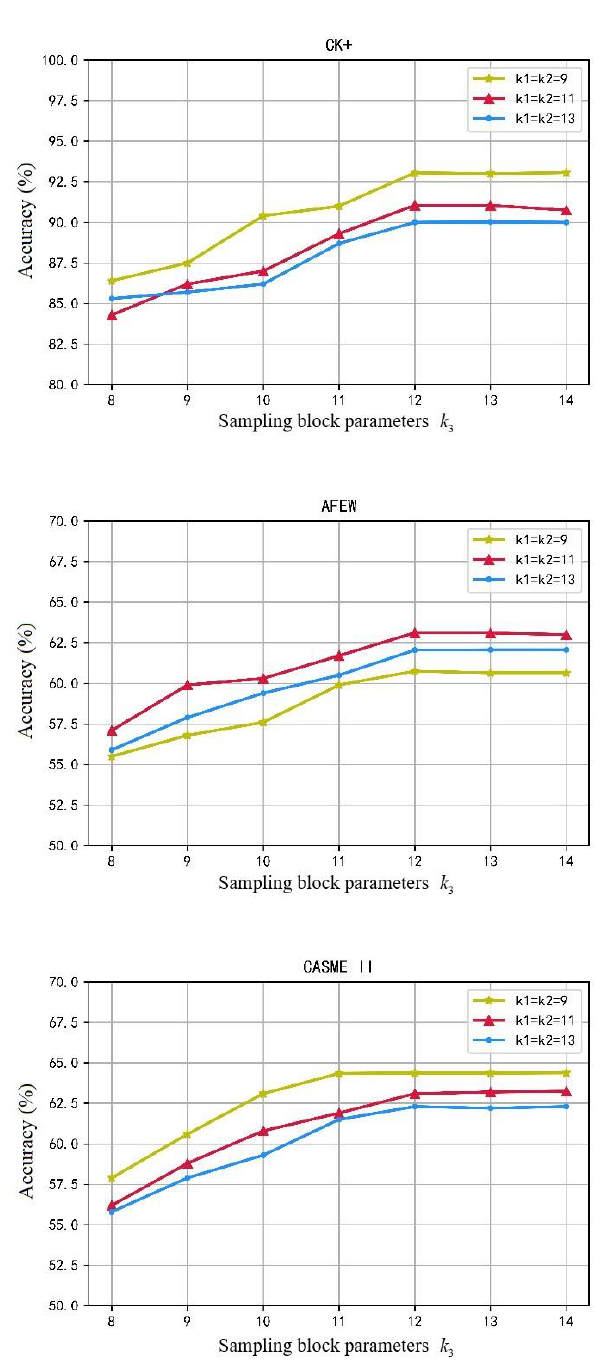
Figure 5. Recognition rate curve for SE-3DPCANet with different parameters.